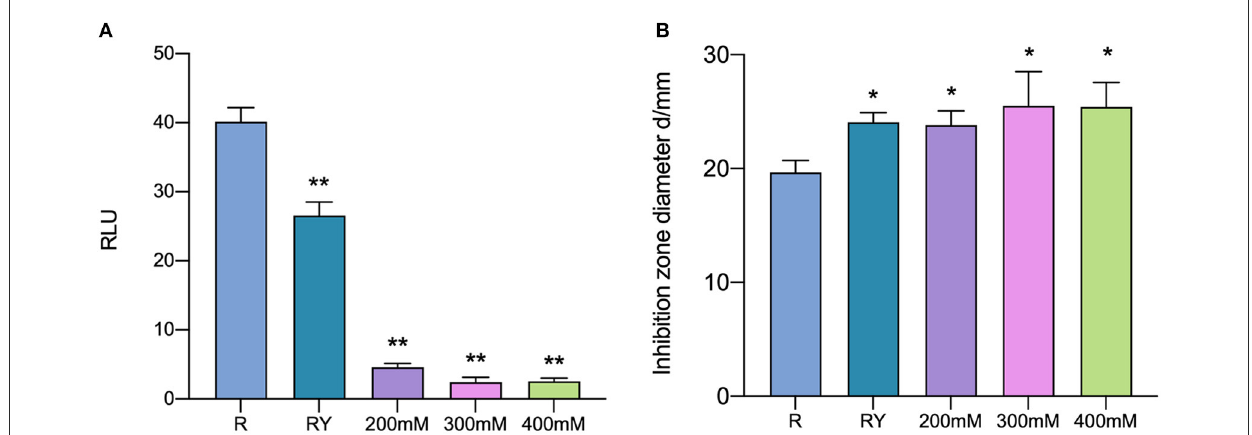
FIGURE8 AI-2 activity (A) and the antibacterial activity (B) in co-culture with the addition of D-ribose. R means mono-culture of L. paraplantarum RX-8 at 37 ◦ C; RY means bacteriocin-inducing co-culture of L. paraplantarum RX-8 and W. anomalus Y-5 at 37 ◦ C as a positive control; 200/300/400mM means co-culture of L. paraplantarum RX-8 and W. anomalus Y-5 at 37 ◦ C with 200, 300, and 400mM D-ribose. * p < 0.05, ** p <